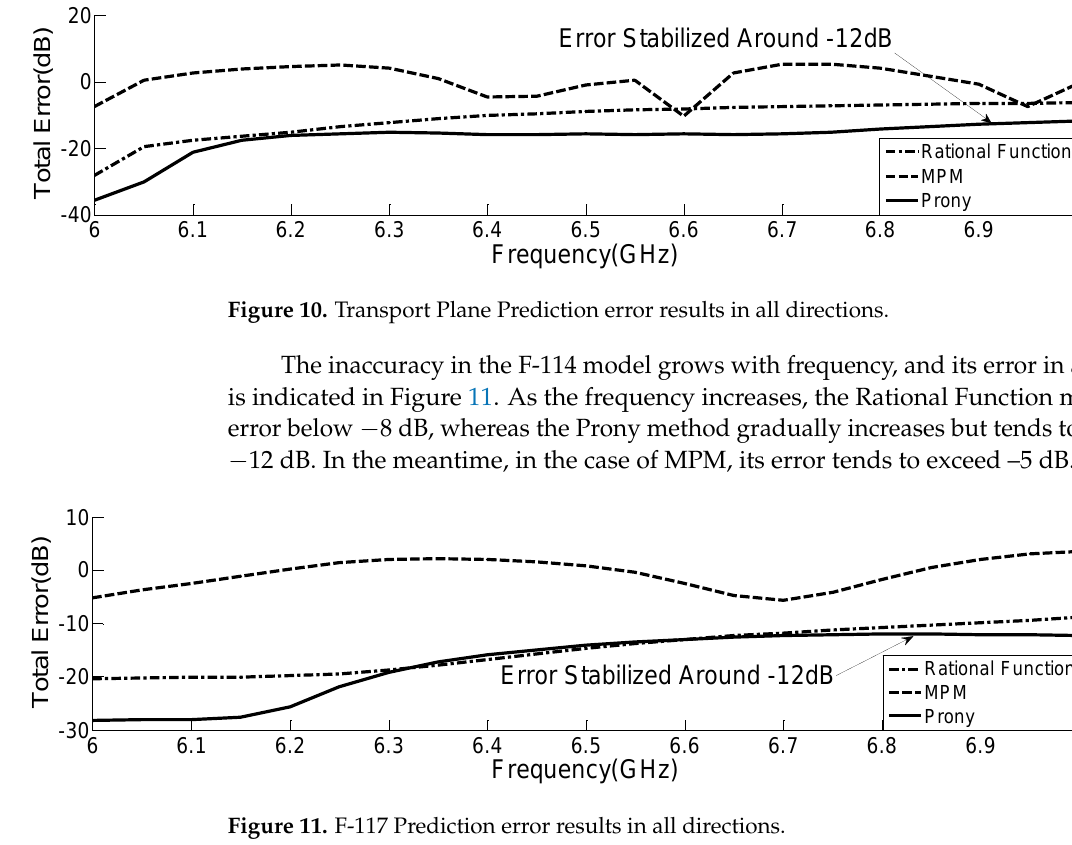
Figure 9. Jet Plane Prediction error results in all directions.